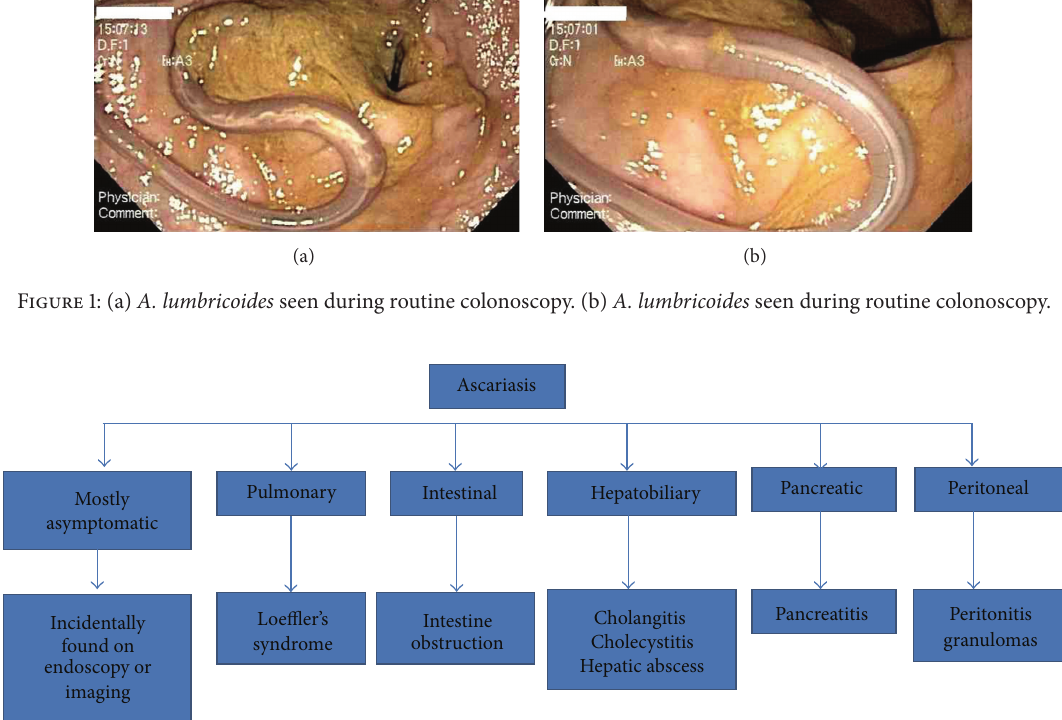
Figure 2: Clinical types of